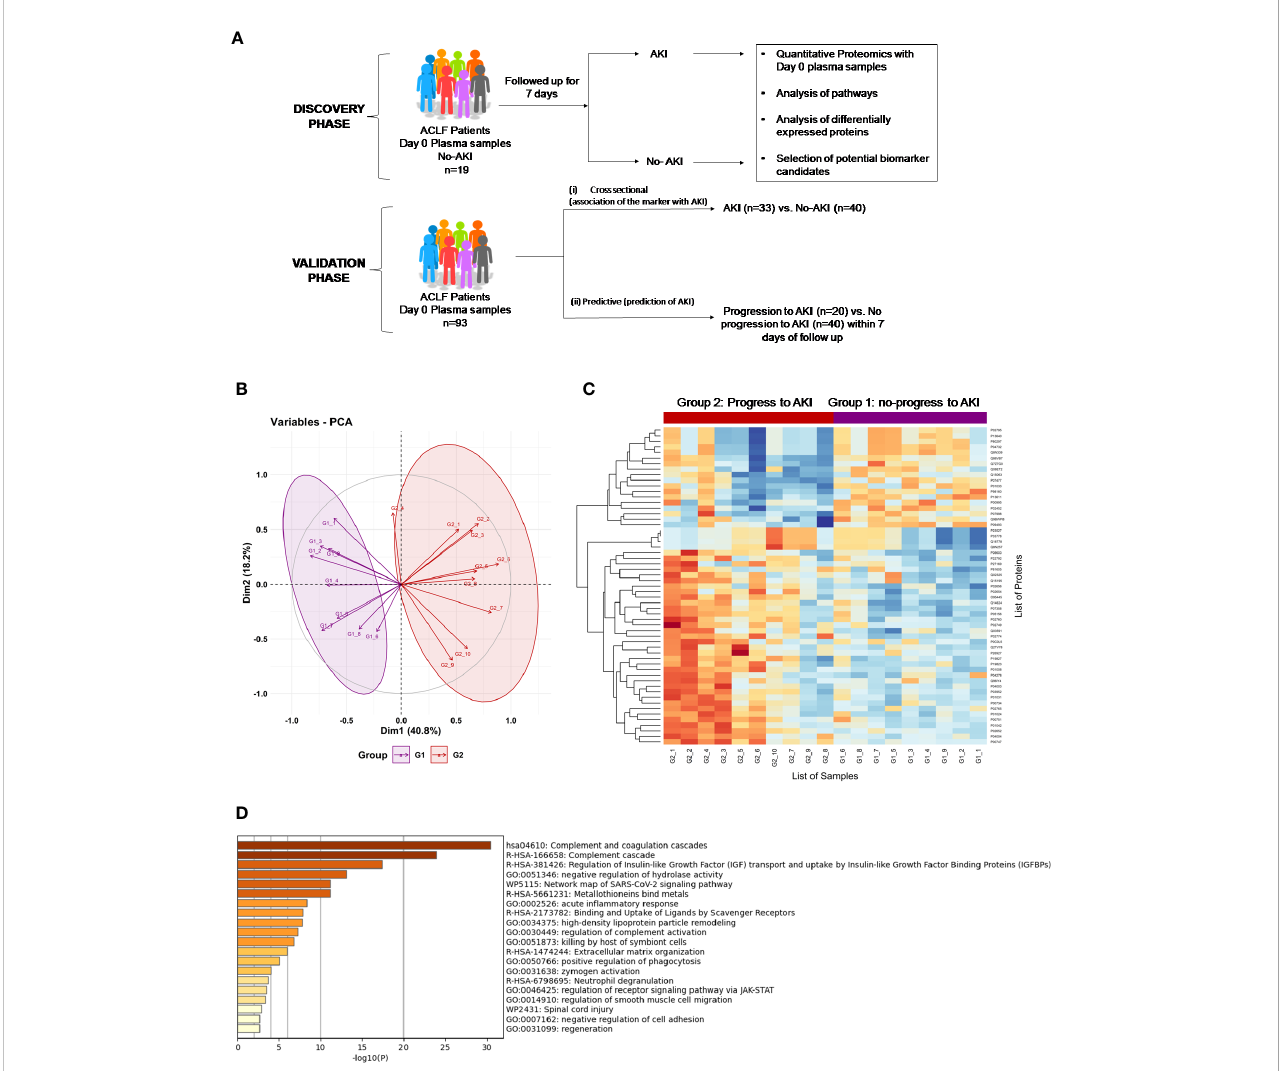
FIGURE 1 Proteomics Analysis of ACLF patients who progress to AKI vs ACLF patients who do not progress to AKI. (A) Study design of proteomics analysis. (B) PCA analysis clusters patient population into two distinct groups based on plasma proteome pro fi les, (C) Heatmap of protein expression in the two different groups (G1: ACLF patients who do not progress to AKI and G2: ACLF patients who progress to AKI) and (D) Pathways analysis using Metascape suggests an upregulation of coagulation, acute in fl ammatory pathways and metal binding proteins metallothioneins as major pathways upregulated in the plasma of ACLF patients who progress to